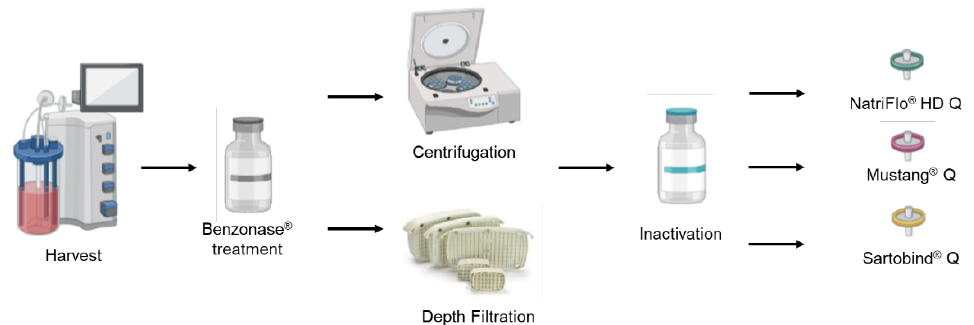
Figure 1. Downstream processing flow and alternative clarification steps and ion exchange chromatography steps compared in the study.